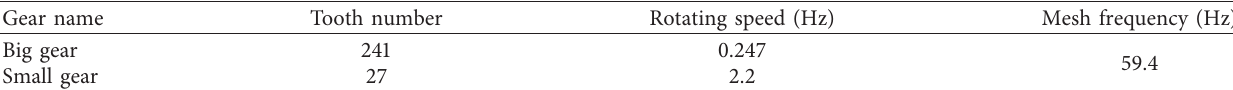
Table 1: Parameters of the open gears.